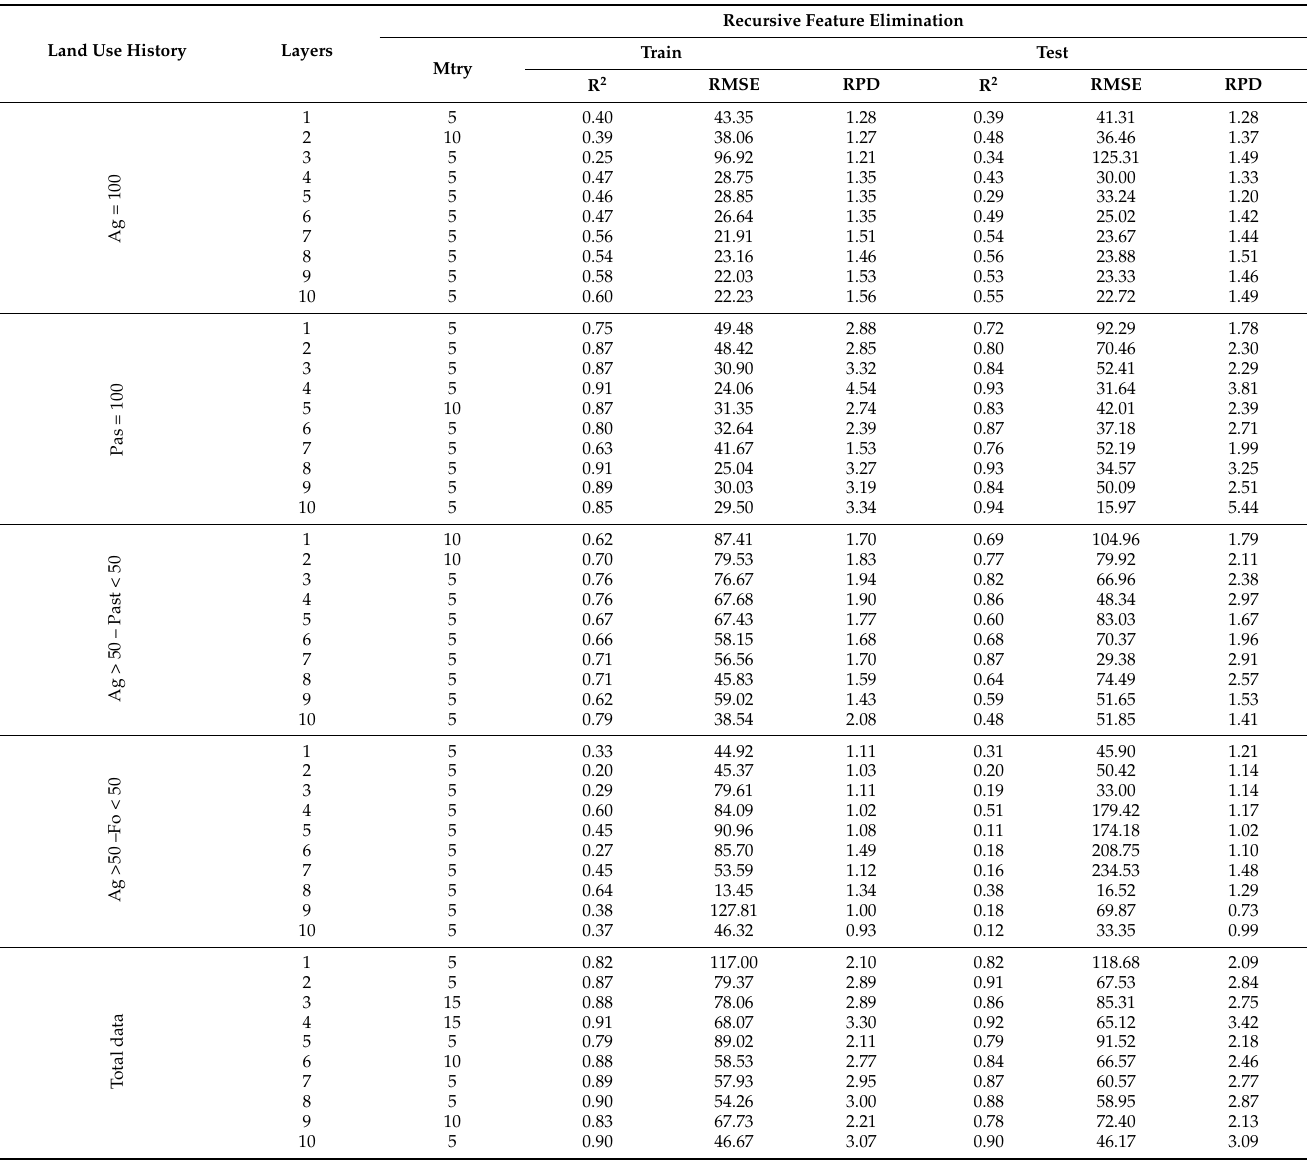
Table 4. The performance of random forest with variables selected with Recursive Feature Elimination.